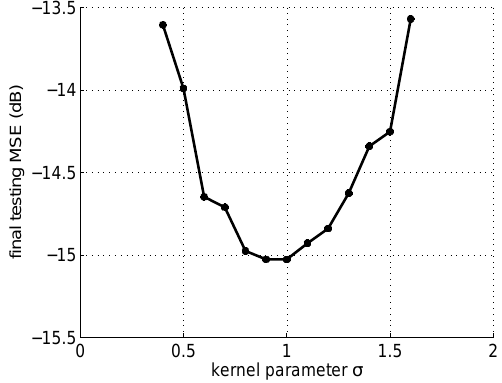
Figure 3. The final testing MSE curve of KLMS-RFN algorithm with the kernel parameter σ varying from 0.4 to